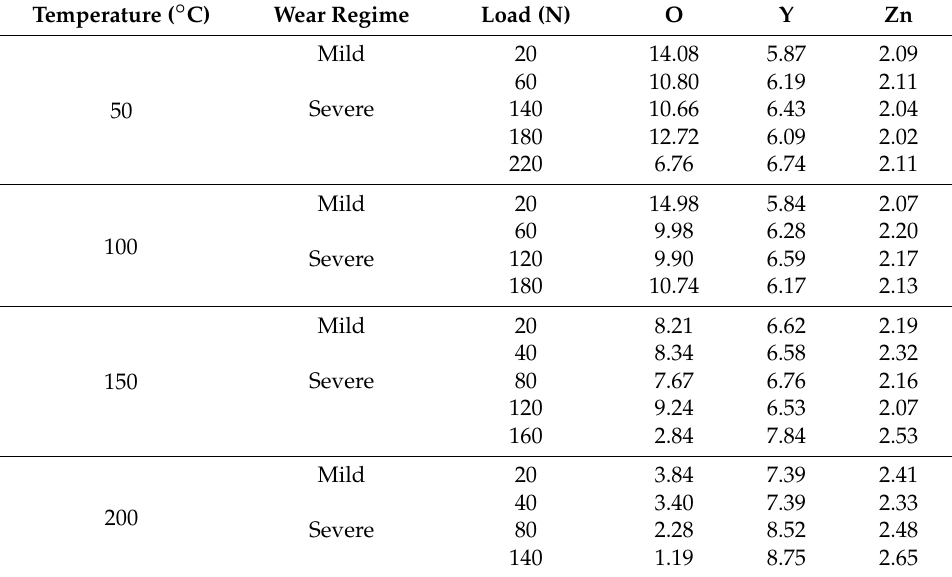
Table 1. Chemical composition of worn surfaces at 0.8 m/s